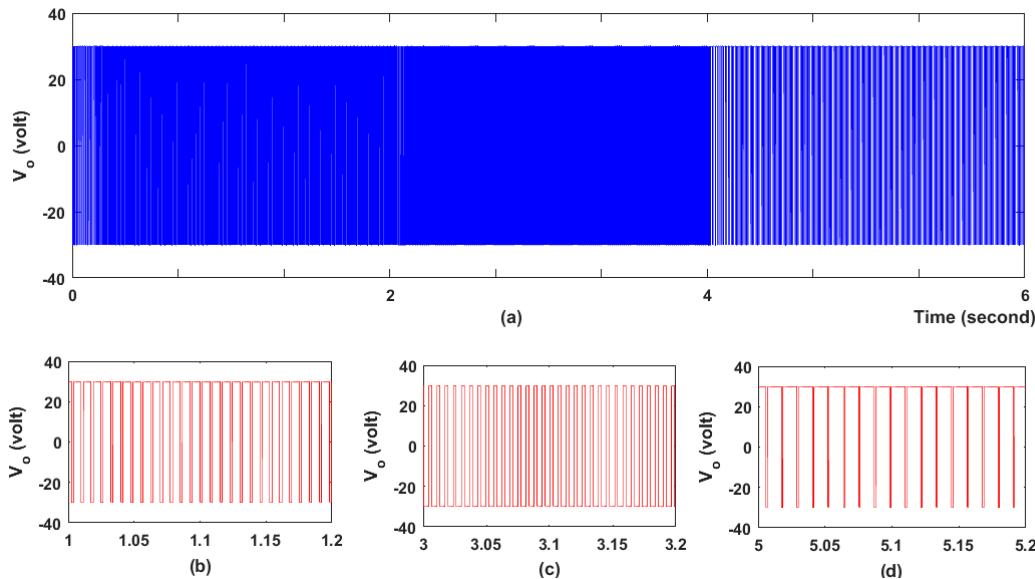
Figure 7. Converter output voltage during: ( a ) simulation time; ( b ) 200 rpm reference speed; ( c ) − 100 rpm reference speed; ( d ) 300 rpm reference speed.